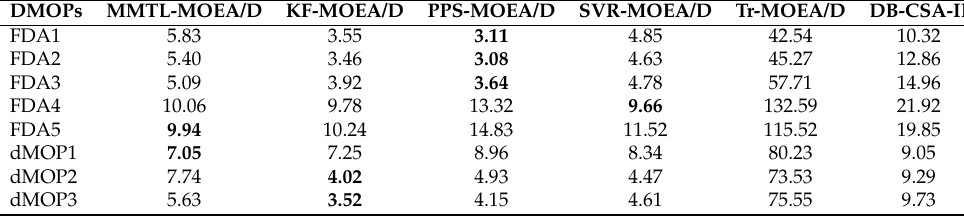
Table 11. Run-times of DMOEAs for Solving FDA and dMOP Test Suites (Unit: